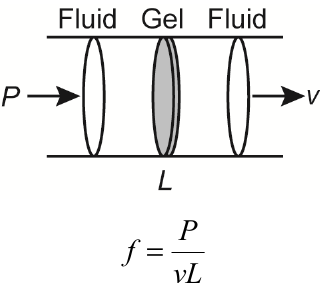
Figure 2. The schematic illustration of the friction measurement.